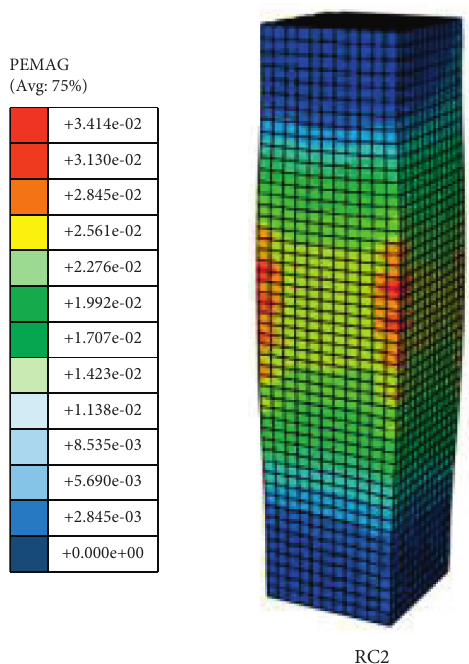
Figure 12: Strain cloud picture of RC2